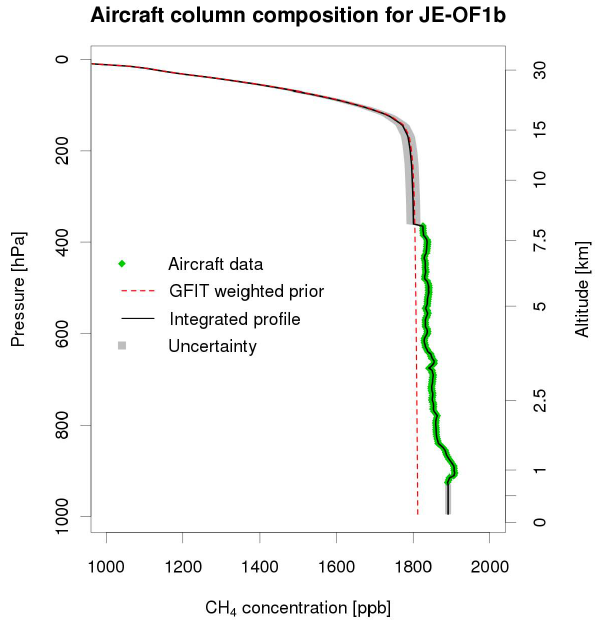
Fig. 5. Example for the extension of aircraft data to a total col- umn (JE-OF1b). The black line is the extended aircraft profile x h . The green partial column represents the aircraft in-situ data. This column was extended by the weighted GFIT a-priori in the stratosphere. The lower part was extended to the ground by adding ground-based in-situ data where available. Otherwise the profile was extrapolated to the surface. The gray area represents the un- certainty of the extended parts. The red line represents the weighted GFIT a-priori profile.